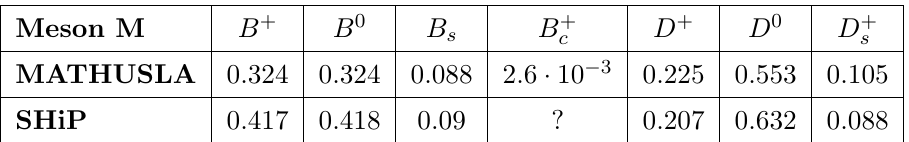
Table 3 . The fragmentation fractions for heavy mesons at the LHC energies [57, 86, 87] and of the SHiP experiment [24, 88]. For SHiP the contribution of (cid:13)avoured baryons or quarkonia states can be neglected, see [24]. For the LHC energies, the remaining 20-25% come of all heavy (cid:13)avour quarks hadronize into baryons, mostly (cid:3) b states